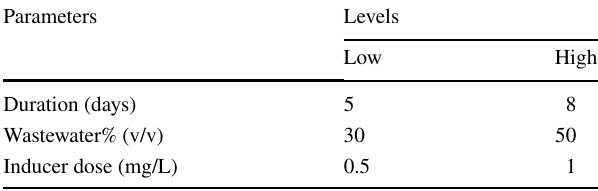
Table 1 Different factors used in the experiment and their levels